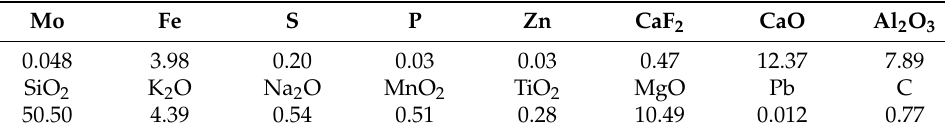
Table 2. Compositions of molybdenum ore, shown as a percentage.